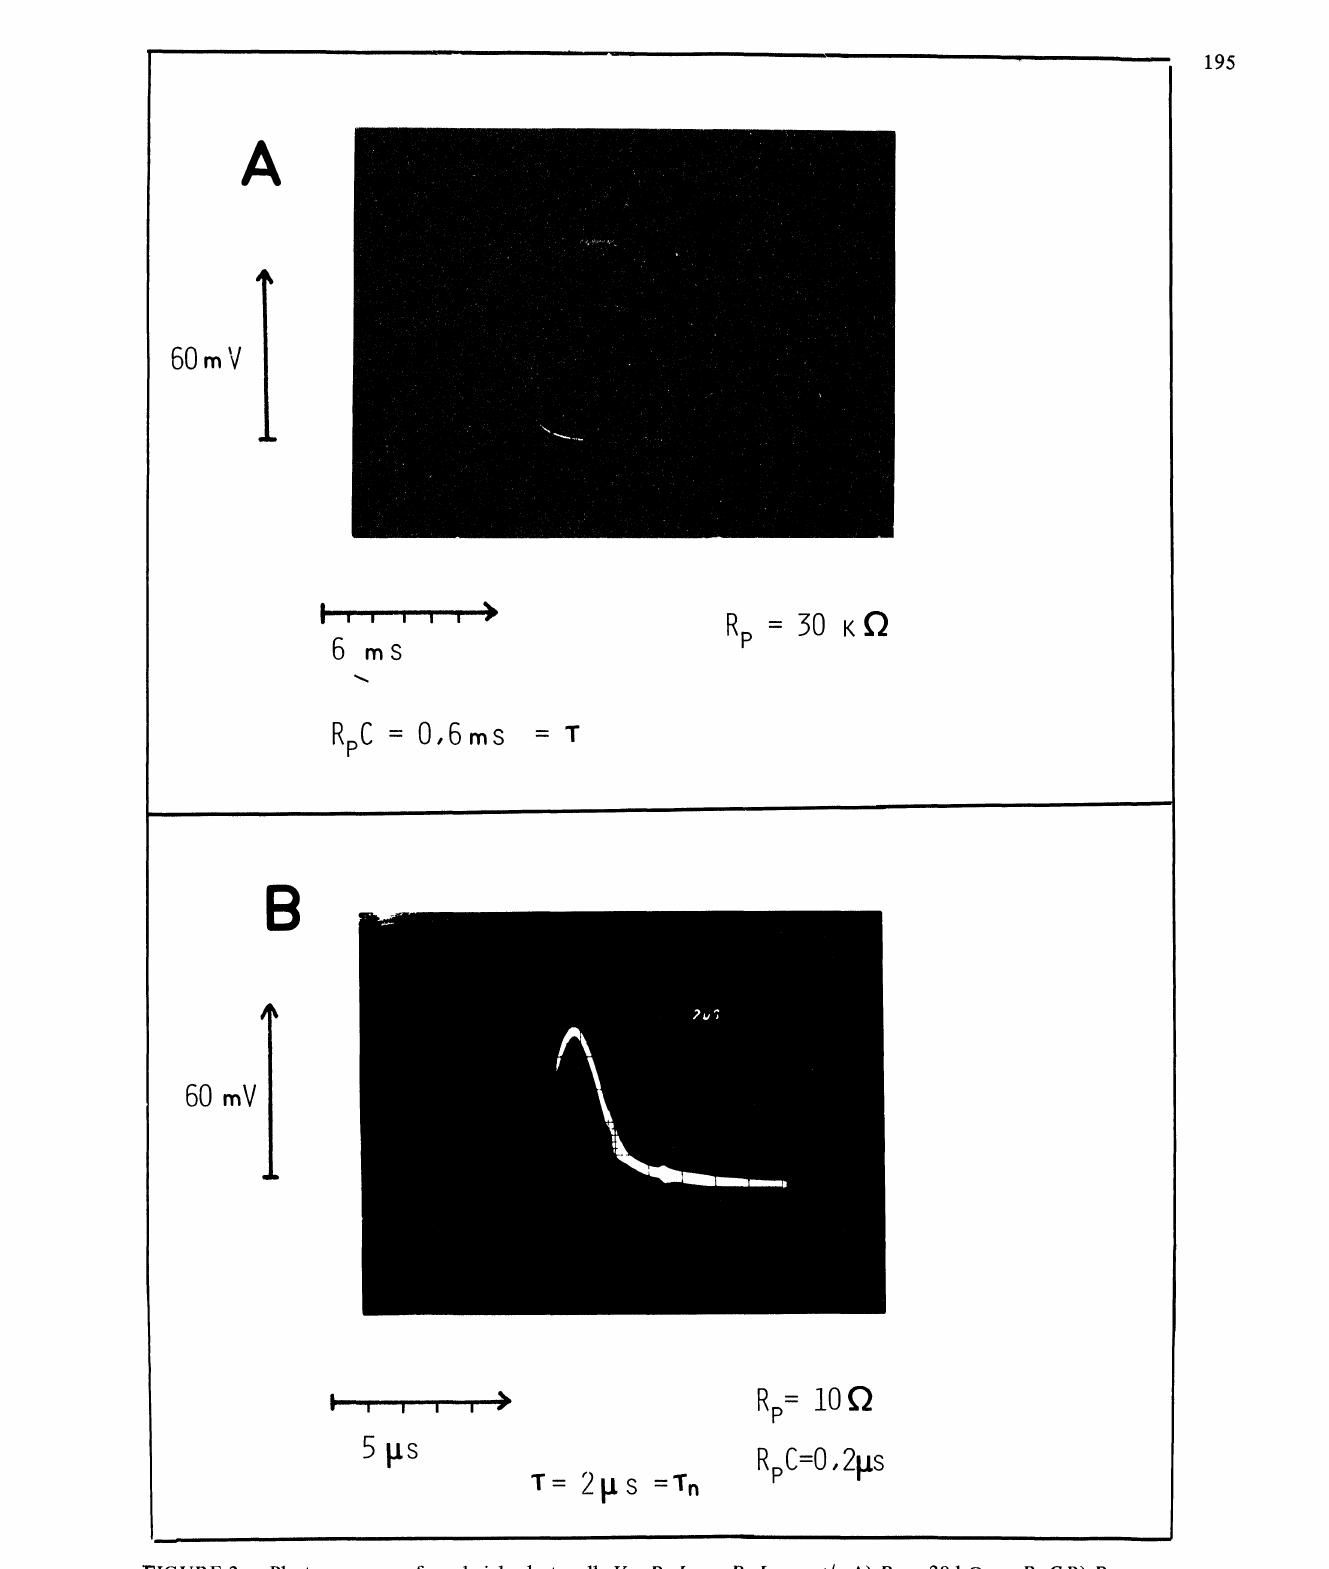
FIGURE 2 Photoresponse of sandwich photocells V Rplph RpI exp t/r A) Rp 30 kS2 r RpC B) Rp = rn 10 s2